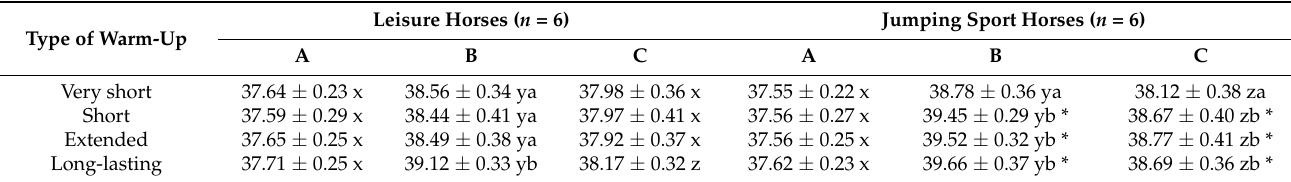
Table 3. Horse rectal temperature ( ◦ C) depending on the type of warm-up (mean ± SD). Type of Warm-Up